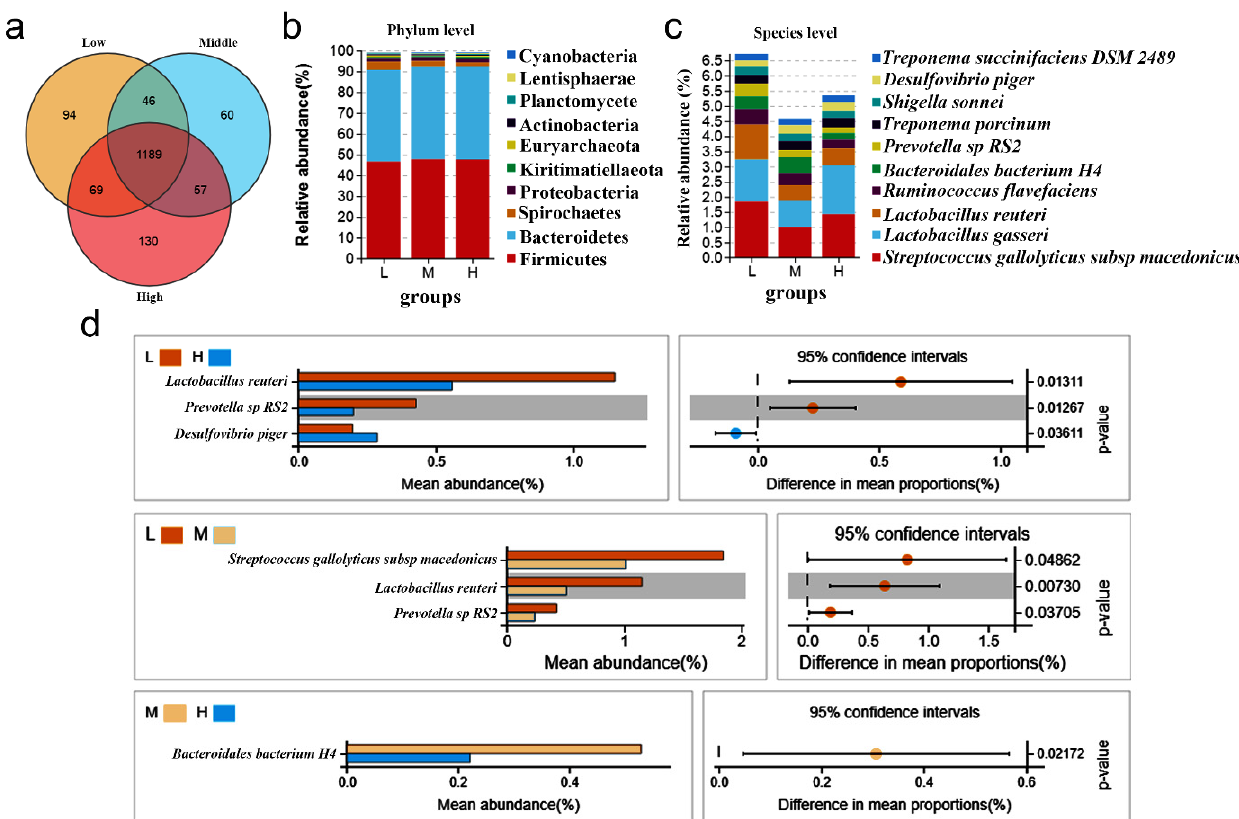
Figure 2. Microbial composition and diversity among the groups with different backfat thickness. ( a ) Venn plot of OTU numbers in each group with different backfat thickness. ( b ) Summary of bacterial phylum detected in the three groups. ( c ) Summary of bacterial species detected in the three groups. ( d ) Significance analysis of species abundance between different backfat thickness groups based on the Welch’s t -test.